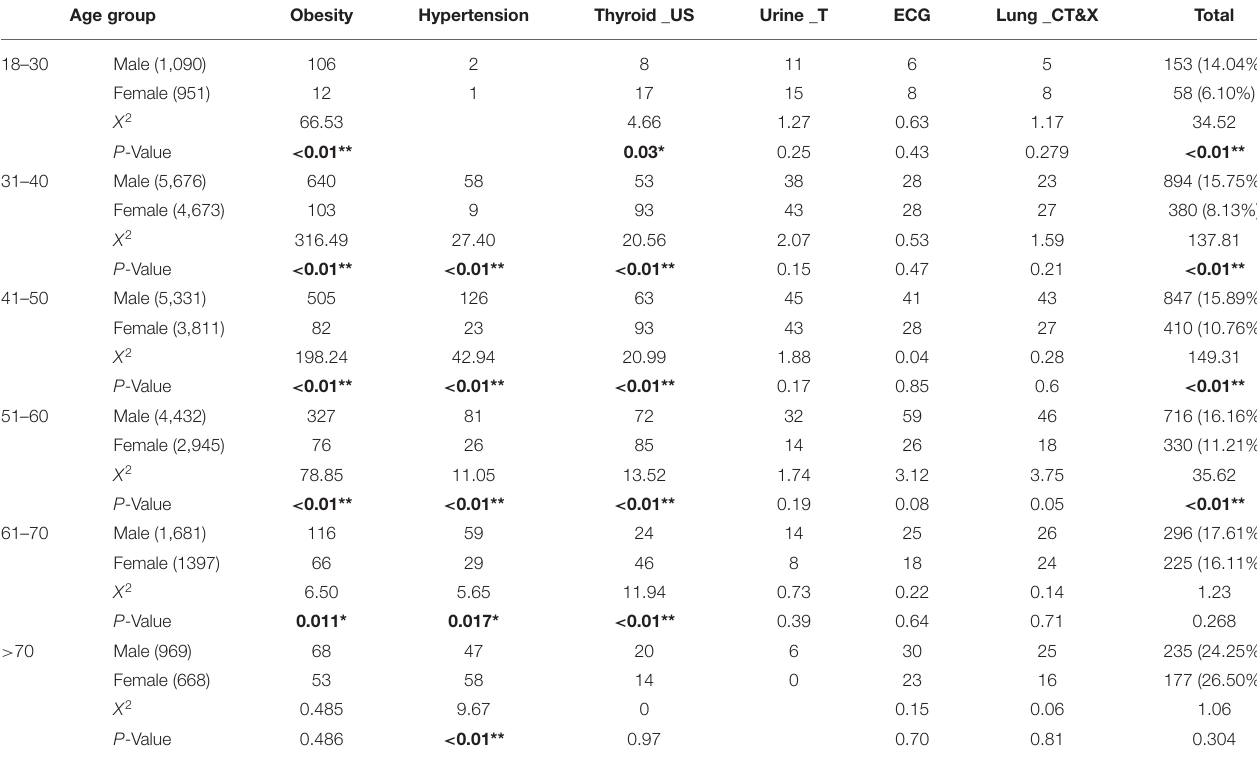
TABLE 6 | The significance analysis of critical values for different ages and genders.